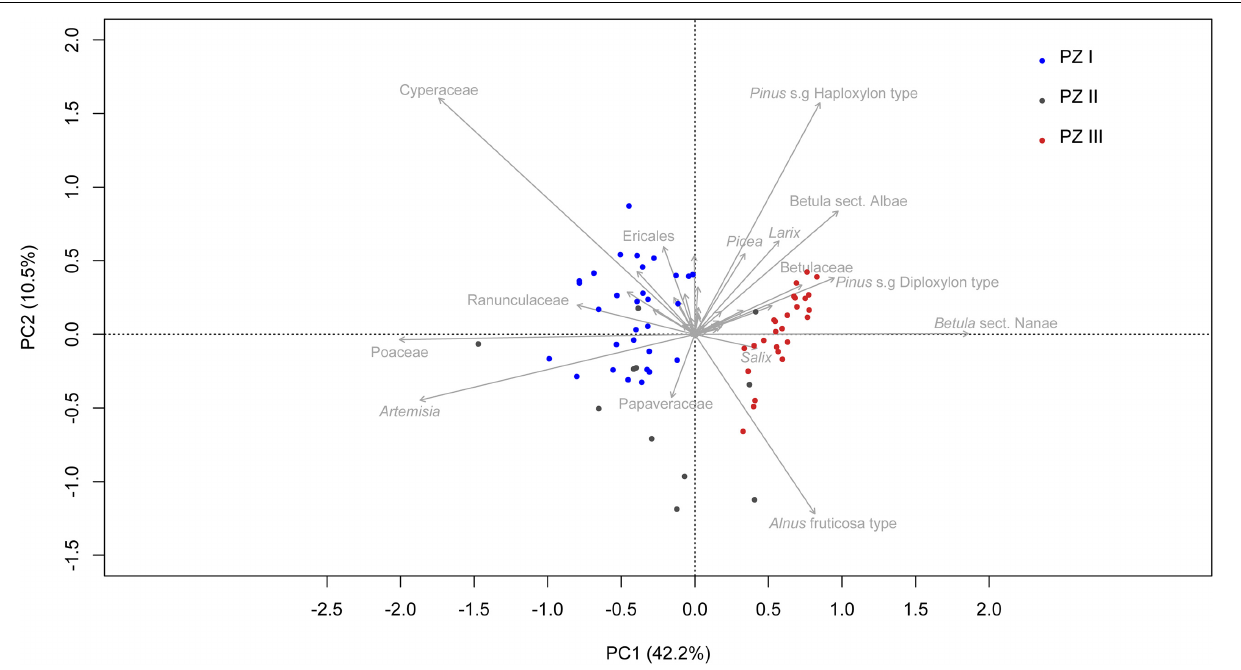
FIGURE 6 | Principal component analysis (PCA) biplot of terrestrial pollen taxa. Only the names of the 15 taxa explaining the most variance are printed. Samples are colored according to their corresponding zone. The explained variances of the two principal components (PC1 & 2) are shown in brackets.